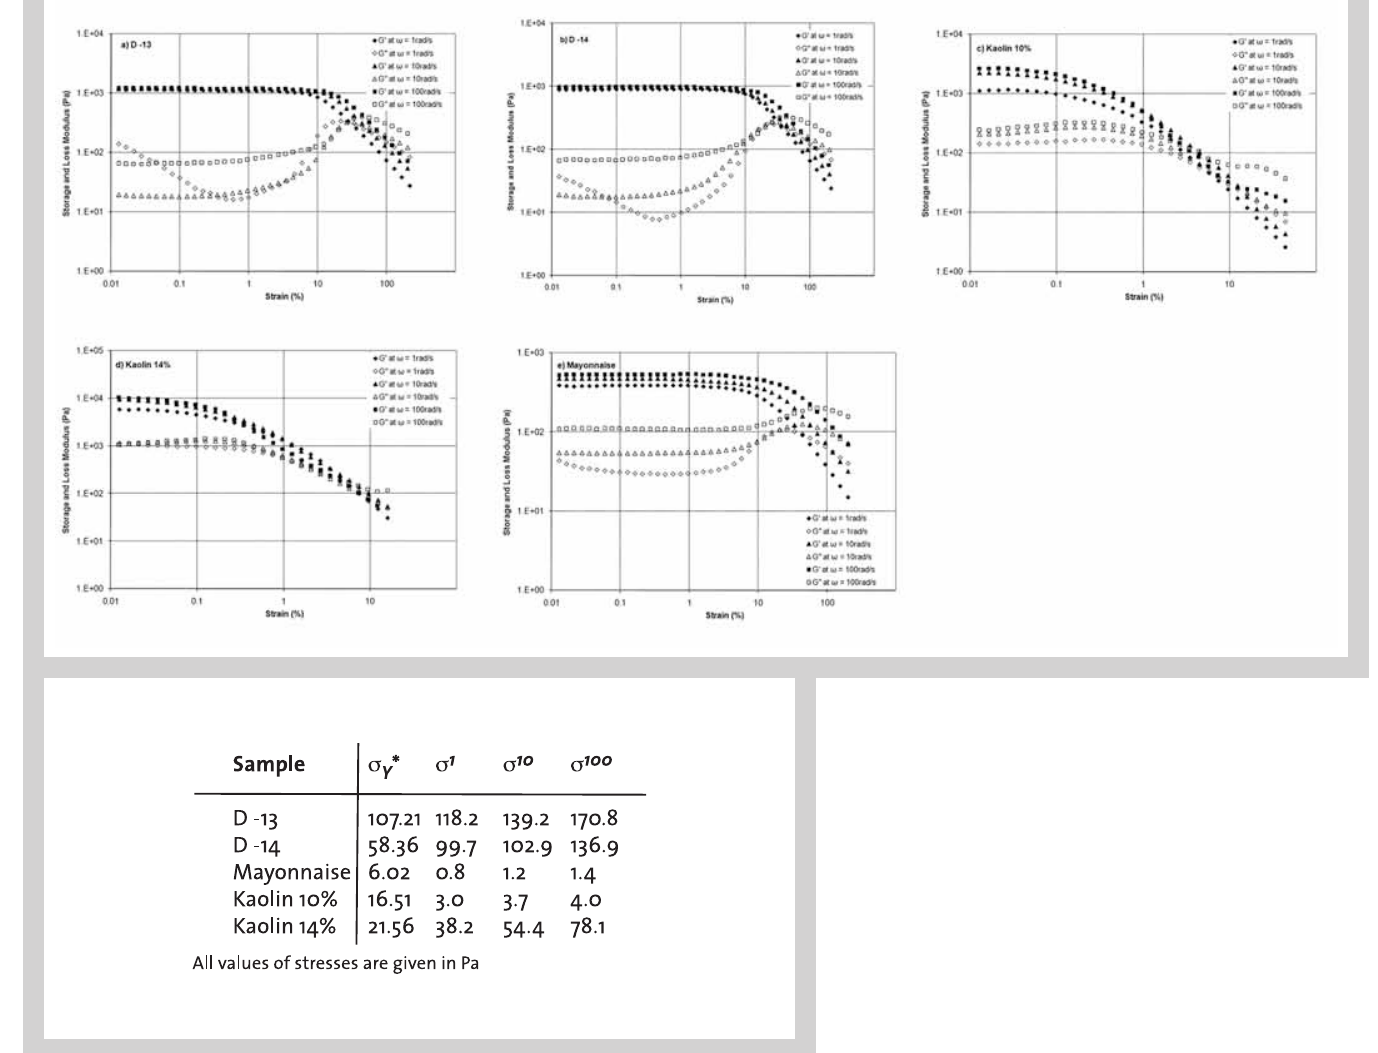
Figure 3 (above): Results of amplitude sweep experiments at three angu- lar frequencies for different samples. Table 3 (below): Summary of the experimen- tally obtained values of char- acteristic